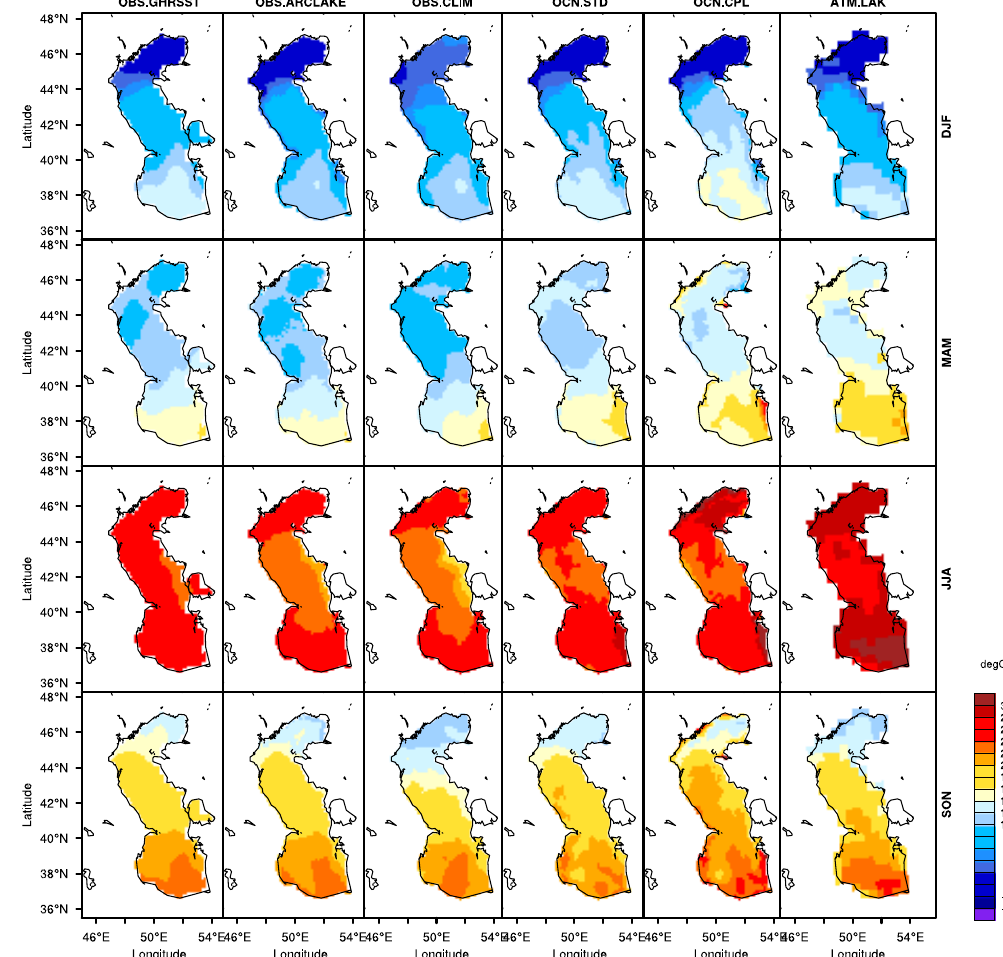
Fig. 8. Seasonal sea surface temperature climatology of OCN.STD, OCN.CPL, ATM.LAK simulations and observations (GHRSST, AR- CLAKE and climatology from Ibrayev et al., 2001) for the period 1999–2008.